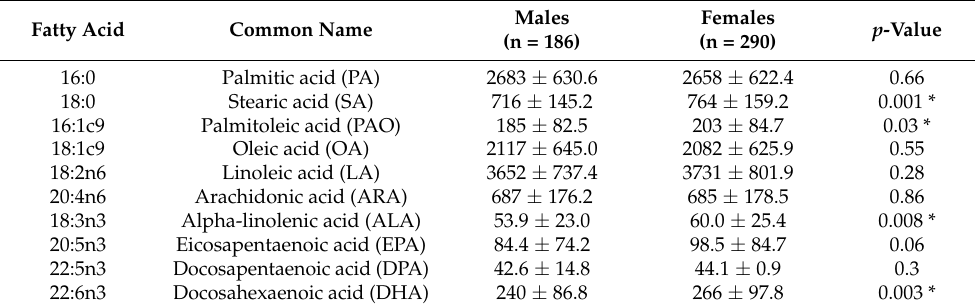
Table 3. Fatty acids concentrations in males and females.